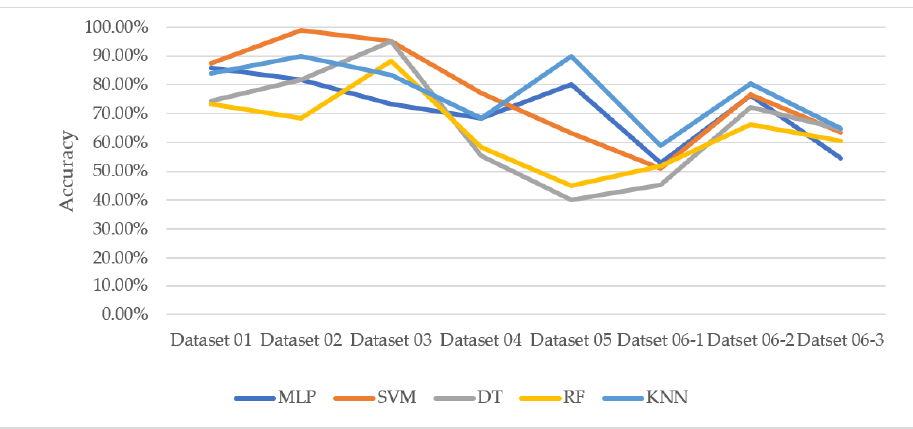
Figure 13. Accuracies for the tested classification algorithms.